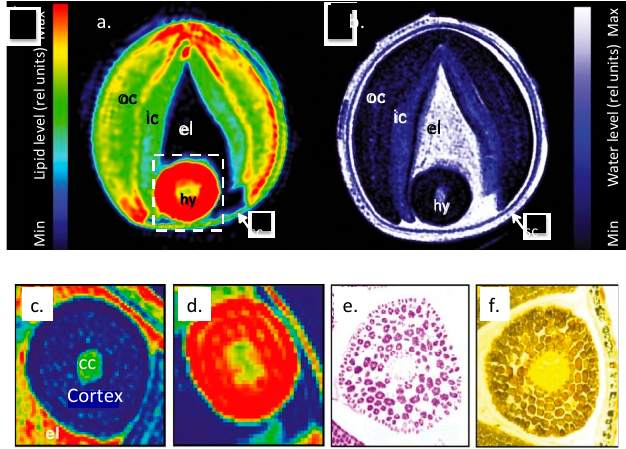
Figure 4. Lipid and moisture storage in Brassica napus seeds ( a , b ) and hypocotyl ( c , d ) visualized by non-invasive MRI. The concentration of water and oil are colour coded red (high); blue, (low). Crucifern immunolocalisation ( e ) and iodine stained starch ( f ) modified from [24] under Creative Commons Deed Attribution licence 2.5. oc,/ic outer/inner cotyledon; el, endosperm; hy, hypocotyl; sc, seed coat; cc, central cylinder.